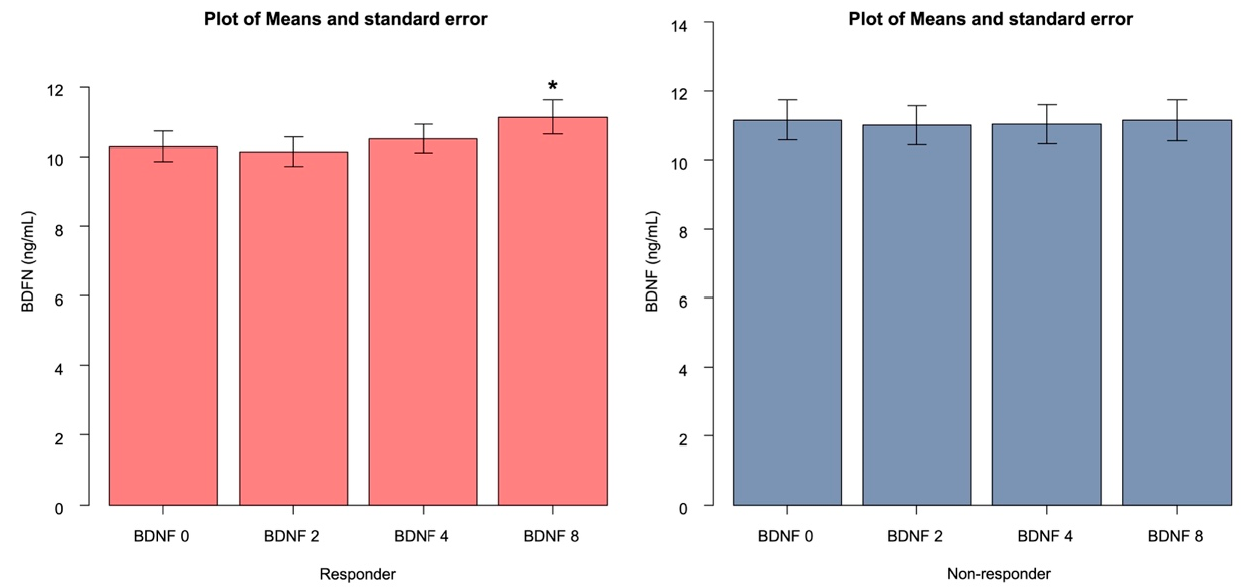
Figure 3. Changes in serum BDNF levels in the responders (red column) and non-responders (blue column). Data was expressed as mean and standard error. ANOVA (global test’s p -value for interaction analysis in mixed effect model; * p = 0.0025.